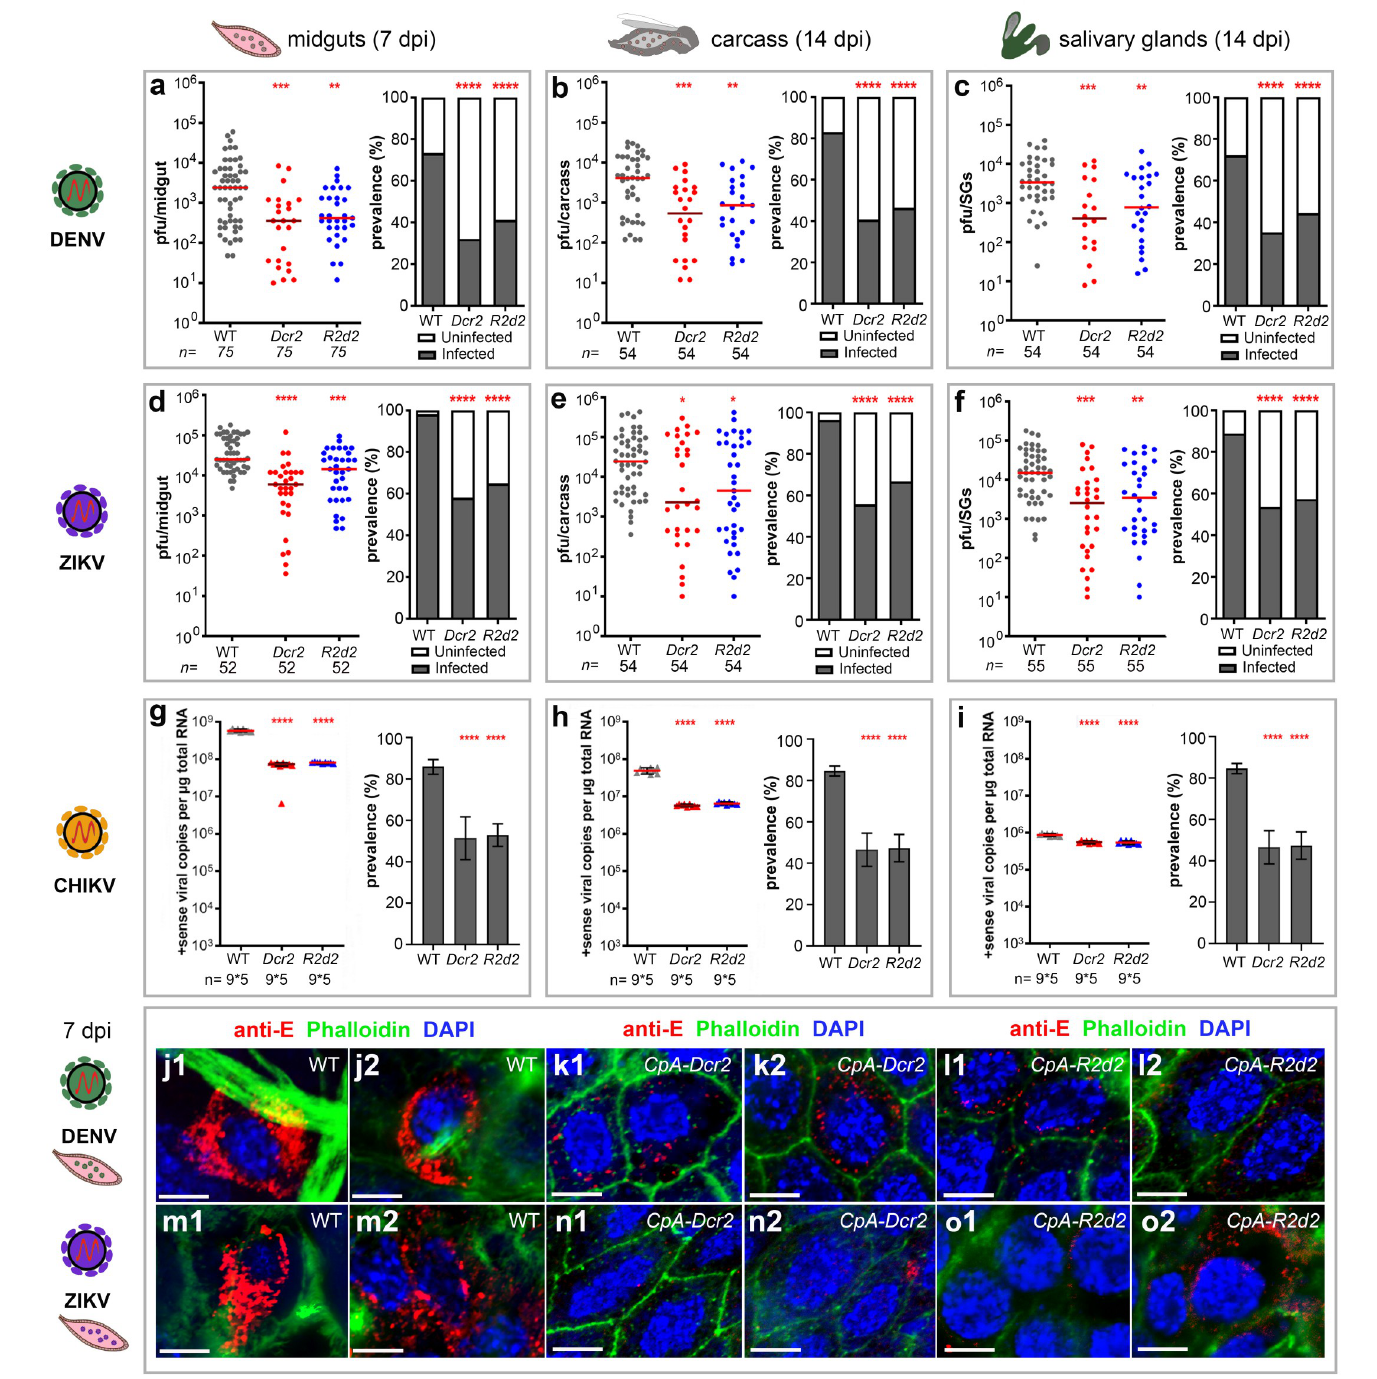
Fig 2. Antiviral effect of RNAi pathway activation on DENV2, ZIKV, and CHIKV infection in transgenic CpA-Dcr2 ( Dcr2 ) and CpA-R2d2 ( R2d2 ) Ae . aegypti . Overexpression of Dcr2 and R2d2 was induced in the transgenic mosquitoes when the infectious blood meal was given at time 0 h. ( a – i ) The viral infection titers and infection prevalence of DENV2, ZIKV (Cambodia), and CHIKV of the CpA-Dcr2 and CpA-R2d2 lines (DENV2: a–c; ZIKV: d–f; CHIKV: g–i) were measured after midgut infection at 7 days PIBM, and dissemination of the virus in the carcass and SGs at 14 days PIBM. Sibling WT Ae . aegypti Liverpool strain was used as a control in parallel in all experiments. Plaque assays were used to determine viral loads and infection prevalence for both DENV2 and ZIKV in individual mosquitoes, and qRT-PCR was used to determine CHIKV viral loads in a pool of 5 mosquitoes, along with CPE assay for the determination of infection and dissemination of virus. Horizontal red lines indicate the median of the viral loads. At least 3 replicates were pooled for the statistical analyses, using the Mann–Whitney test to compare median virus titers and